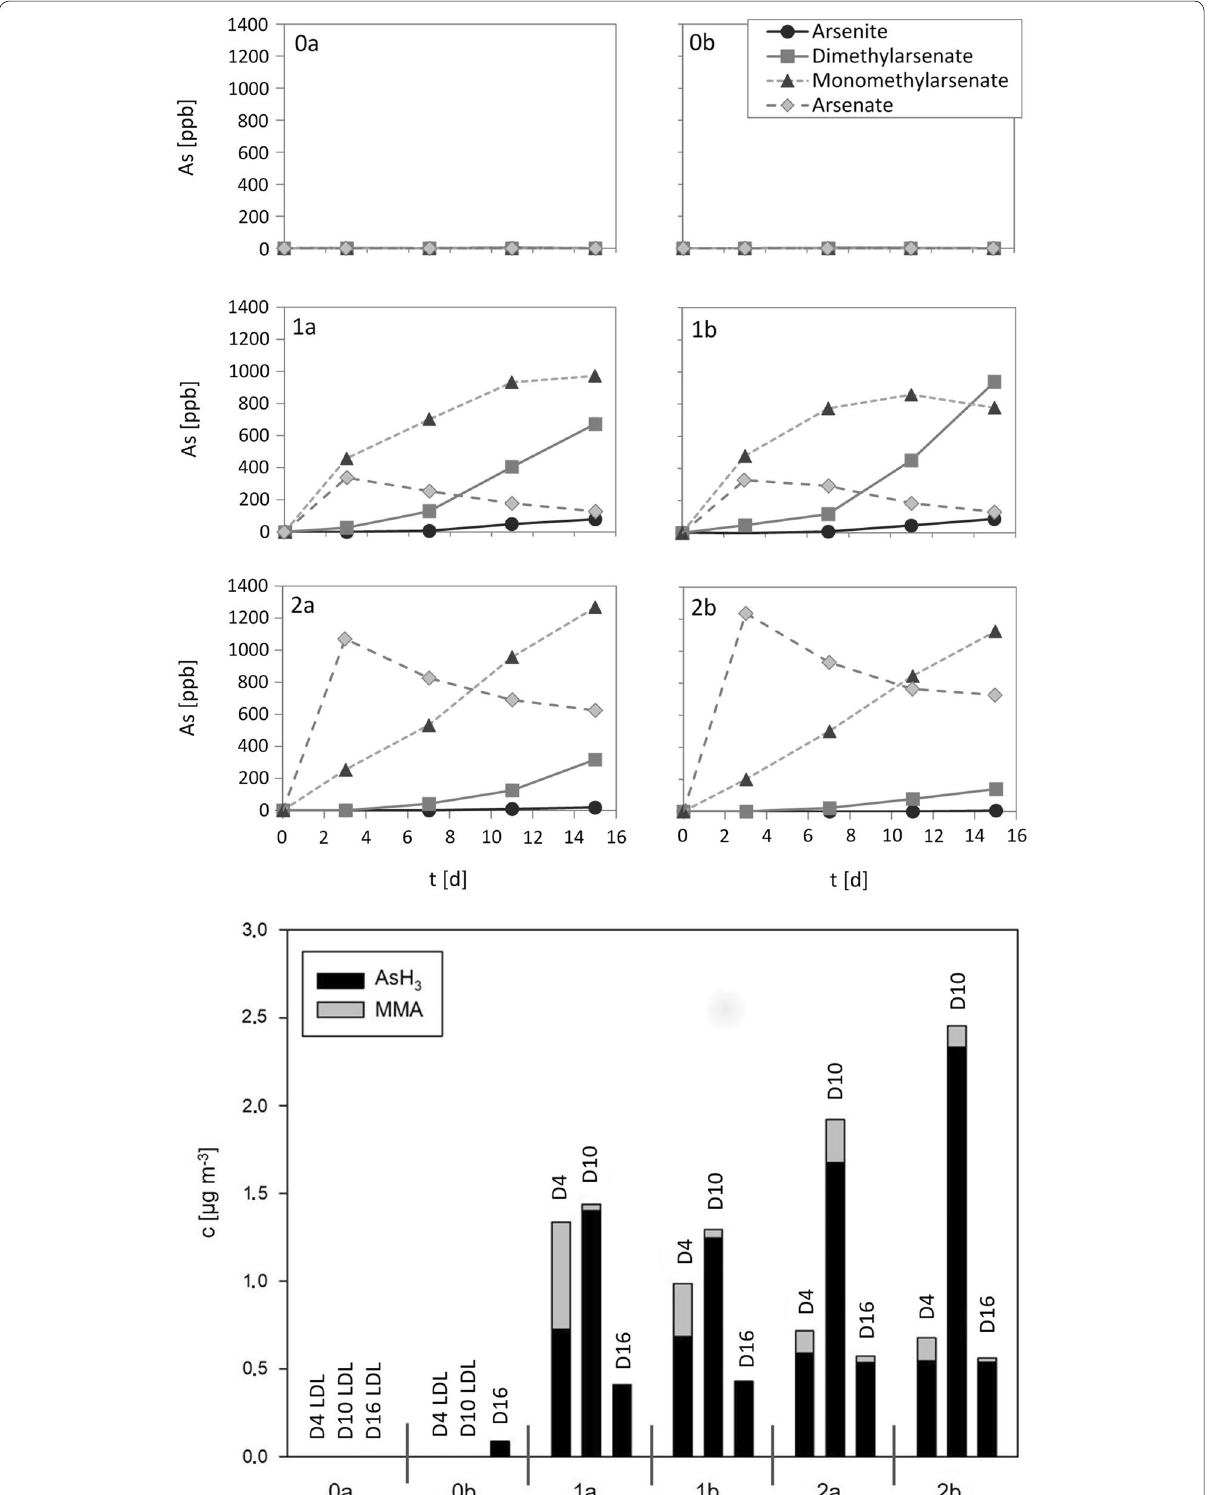
Fig. 5 As species in the liquid (top) and gas phases (bottom) of the satellites to the biogas plant (plant #1). Satellites 0a and b (controls) contained no additional As, satellites 1a and b contained 30 µM (2.25 mg L − 1 ) of additional As, and satellites 2a and b 60 mM (4.5 mg L − 1 ) additional As. As was added as NaAsO 2 . Concentrations of As species in the liquid phase are given as